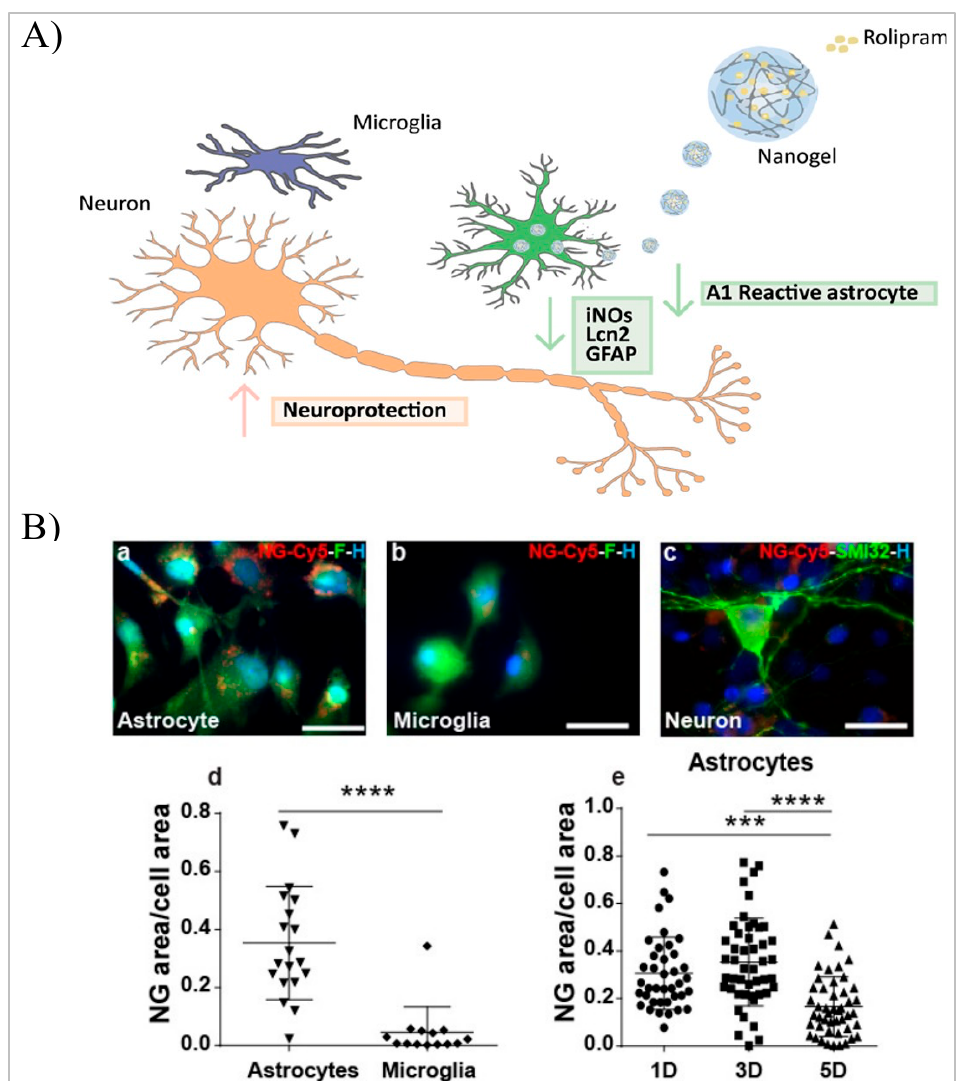
Figure 5. ( A ) Schematic representation of loaded nanogels’ internalization inside astrocyte cells, and subsequent neuroprotective effect. ( B ) Characterization of nanogels’ uptake in primary cultures of ( a ) astrocytes, ( b ) microglia, and ( c ) neurons. ( d ) The quantification of the nanogel uptake in activated astrocytes and microglia shows a higher degree of internalization in the former. ( e ) The quantification 1, 3, and 5 days after exposure shows a reduced signal due to the degradation of the nanovectors. Scale bar 25 μ m. Statistical significance: *** p ≤ 0.001; **** p ≤ 0.0001. Reprinted with the permission of the American Chemical Society [151].